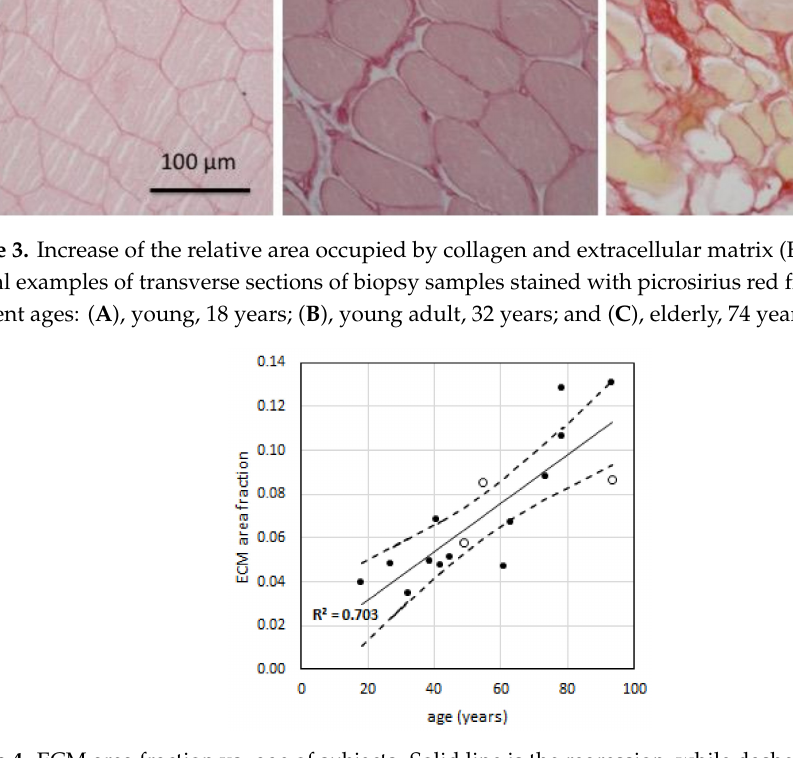
Figure 4. ECM area fraction vs. age of subjects. Solid line is the regression, while dashed lines identify the confidence interval at p = 0.05. Males (N = 13) are indicated with filled circles, while females (N = 3) are indicated with empty